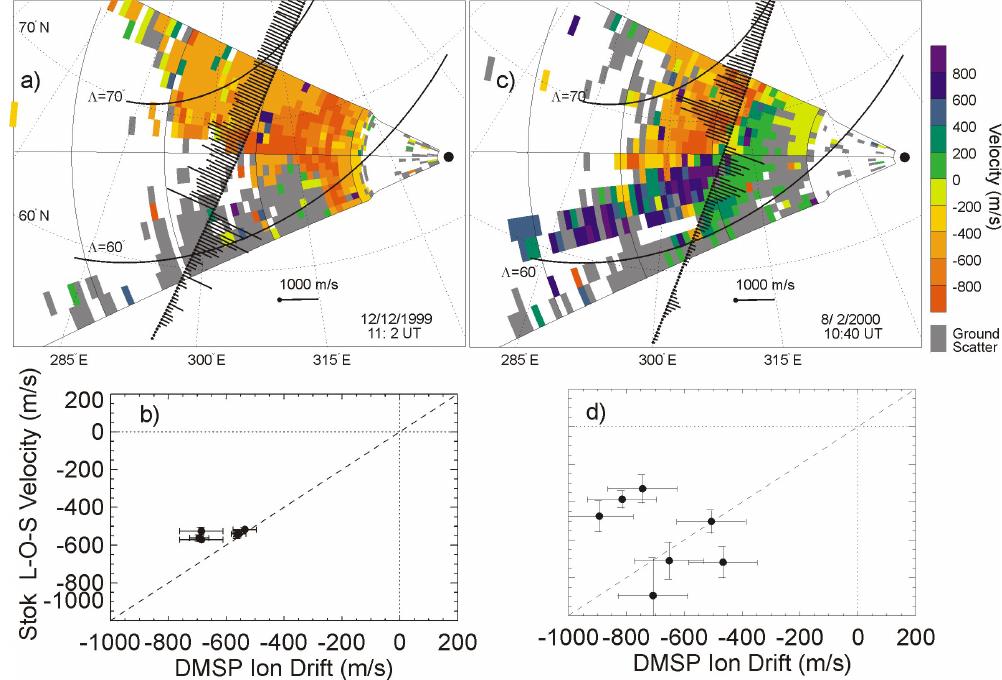
Fig. 2. Two examples of a SuperDARN/DMSP velocity comparison. (a) A Stokkseyri l-o-s velocity map for a 11:02 UT with over-plotted DMSP cross-track ion drifts for the event of 12 December, 1999. (b) A scatter plot of the radar velocity versus the ion drift for the radar cells in panel (a) with a difference between the radar and satellite directions of less than 5 ◦ and the difference in time of less than 2min. Panels (c) and (d) show the same, but for the event of 8 February, 2002 at 10:40 UT. In both examples, the DMSP satellite crosses the radar’s field of view at the approximate time of the scan.